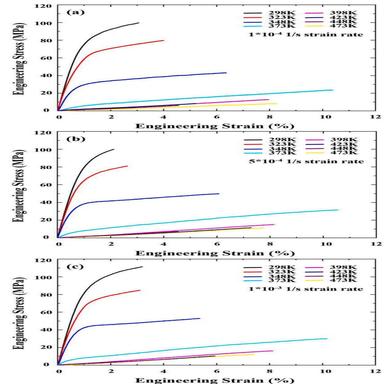
Results of tensile experiment (a)1\10− 4 s − 1 , (b) 5\10− 4 s − 1 , (c) 1\10− 3 s − 1 ..